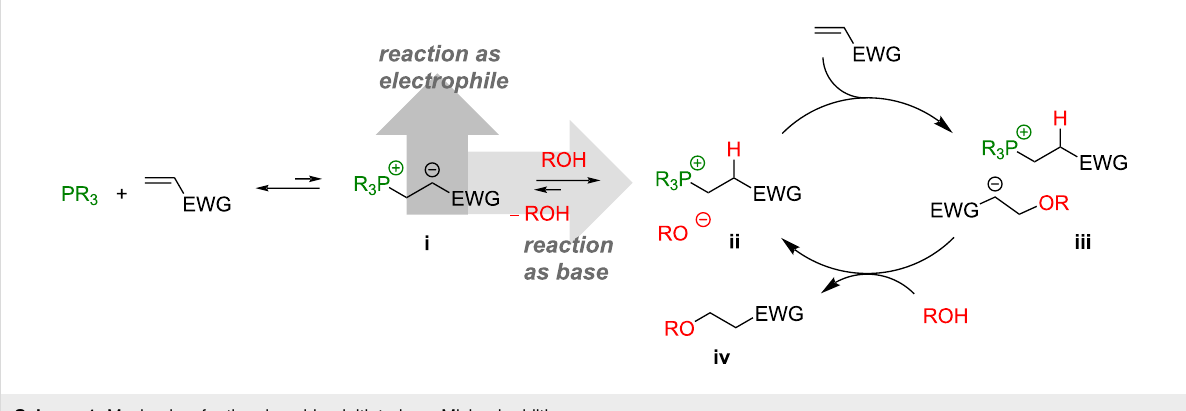
Scheme 1: Mechanism for the phosphine-initiated oxa-Michael